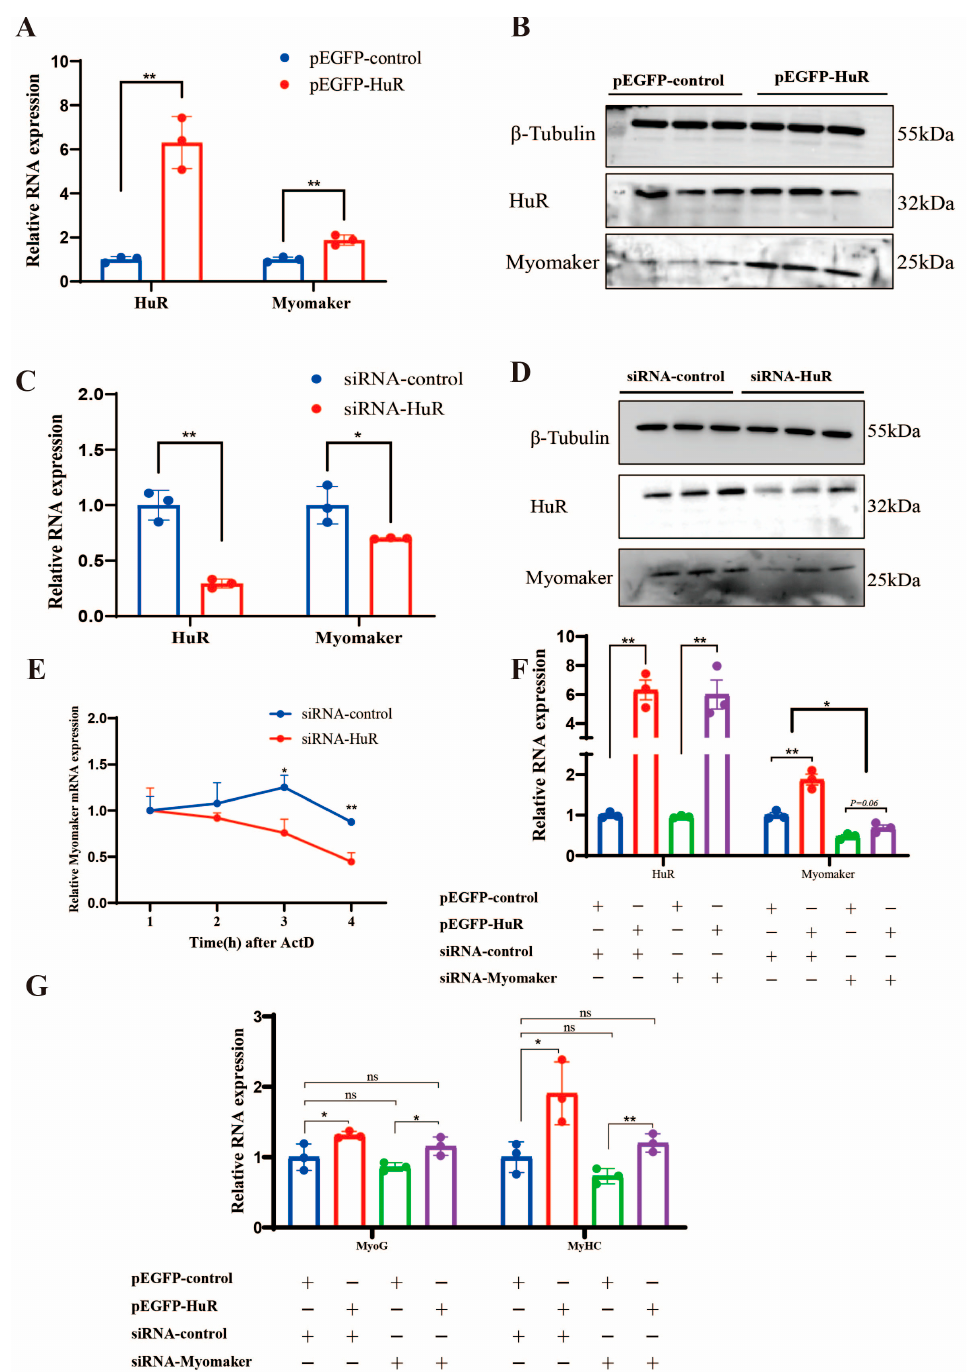
Figure 4. HuR promotes MuSC differentiation by modulating Myomaker stability. ( A ) The expression levels of HuR and Myomaker were determined in MuSCs transfected with pEGFP-HuR or pEGFP- control. ( B ) Myomaker protein levels were determined in MuSCs transfected with pEGFP-HuR or pEGFP-control. ( C ) The expression levels of HuR and Myomaker were determined in MuSCs transfected with siRNA-HuR or siRNA-control. ( D ) Myomaker protein levels were determined in MuSCs transfected with siRNA-HuR or siRNA-control. ( E ) qRT-PCR results showed that HuR knockdown inhibited the stability of the Myomaker mRNA. ( F ) The expression of HuR and Myomaker were determined after treatment with pEGFP-HuR and/or siRNA-Myomaker. ( G ) The expression of MyoG and MyHC was determined after treatment with pEGFP-HuR and/or siRNA-Myomaker. The data are represented by the average of three independent experiments ± SEM, * p < 0.05, ** p <